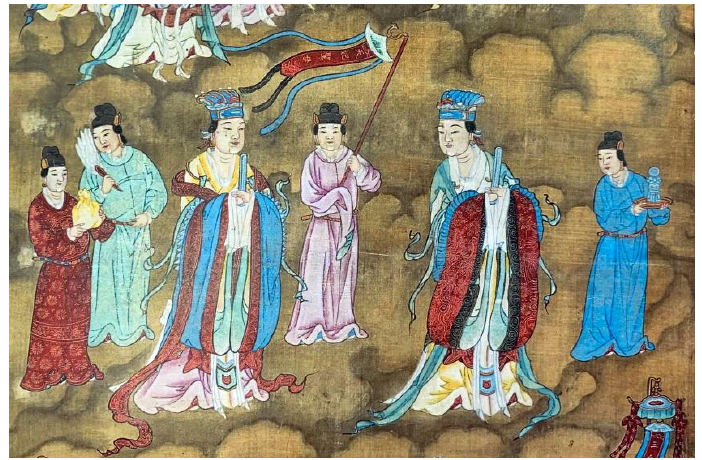
Figure 8. The water and land painting of the Virgin Mary in Xilai Temple in the Ming dynasty. Source: author’s photograph.